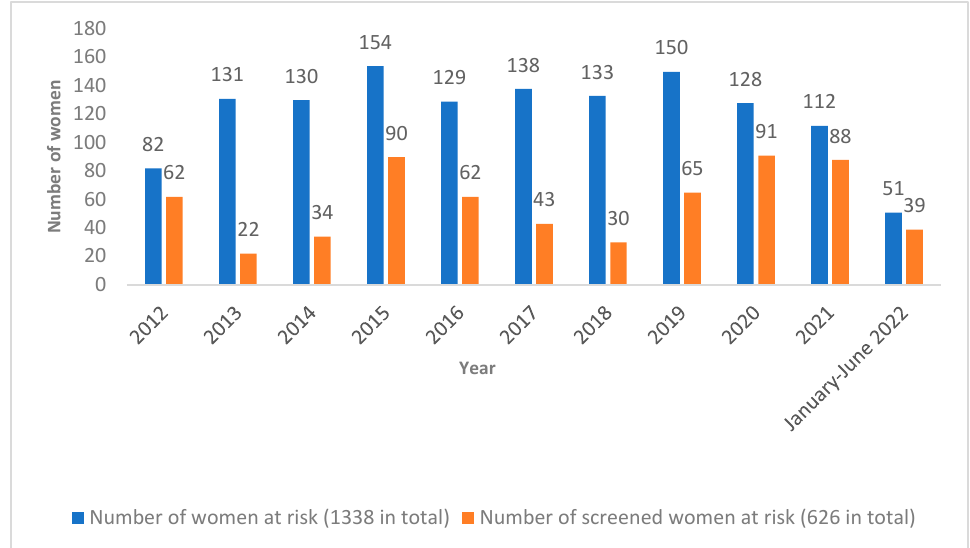
Figure 4. Representation of the total number of deliveries by women at risk per year (blue), and total number of women at risk tested for Chagas disease who gave birth in Careggi University Hospital each year (orange).